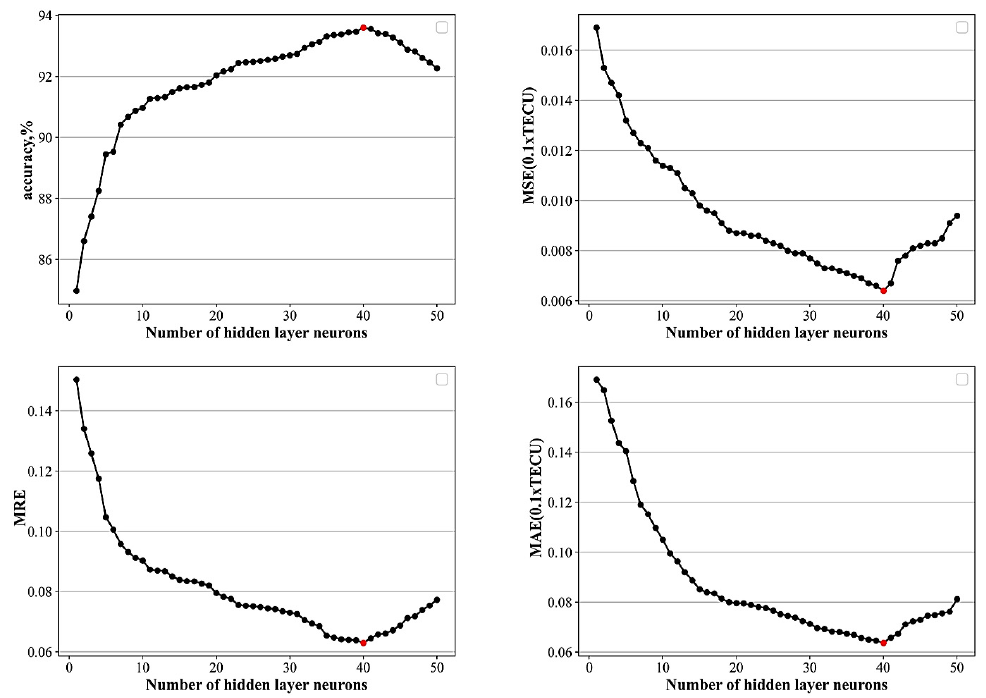
Figure 8. The effects of different number of neurons on prediction performance at A 1 (The red dots represent the optimal values of the evaluation